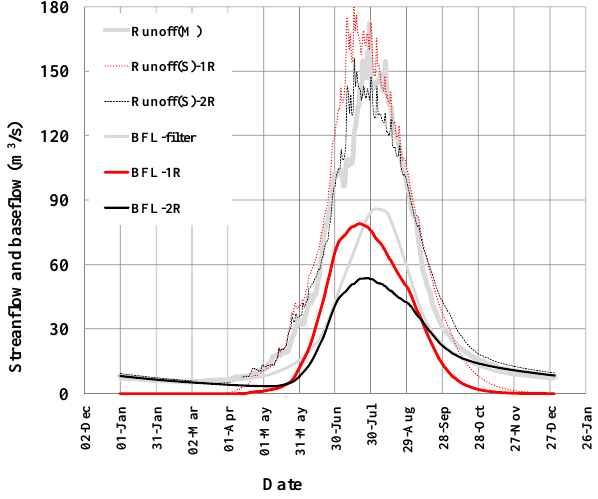
Fig. 7 Comparison of the averaged daily baseflow processes generated by different baseflow Fig. 7. Comparison of the averaged daily baseflow processes gener- approaches (BFL, baseflow; 1R, one-reservoir approach; 1R, two-reservoir approach; filter, ated by different baseflow approaches (BFL=baseflow; 1R=one- reservoir approach; 2R=two-reservoir approach; filter=filter- filter-based baseflow separation approach) based baseflow separation approach).